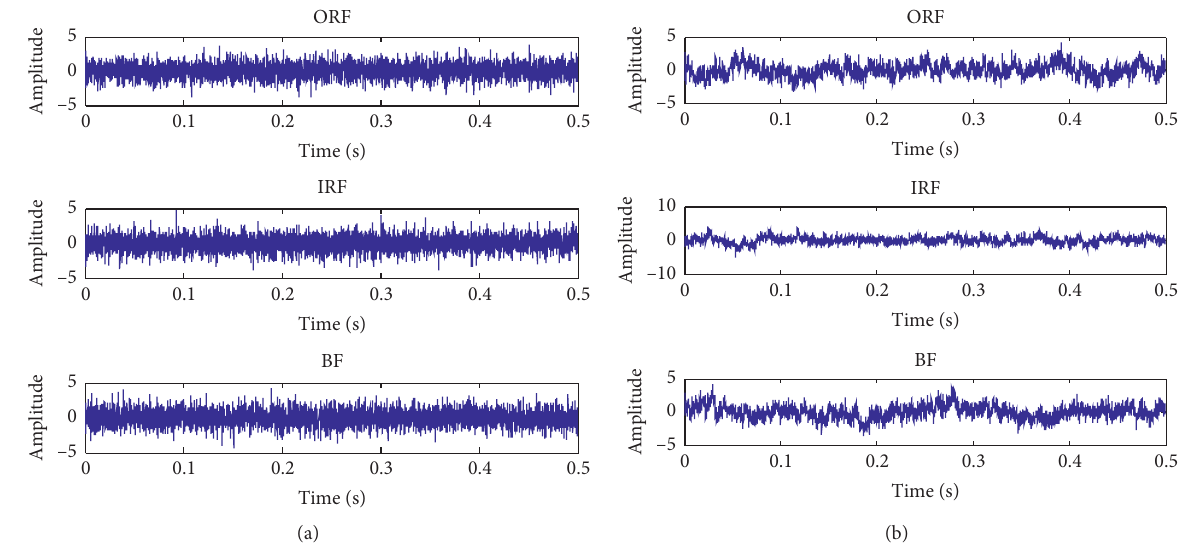
Figure 1: Temporal waveform of three simulation signals under different noises: (a) white noise and (b) pink